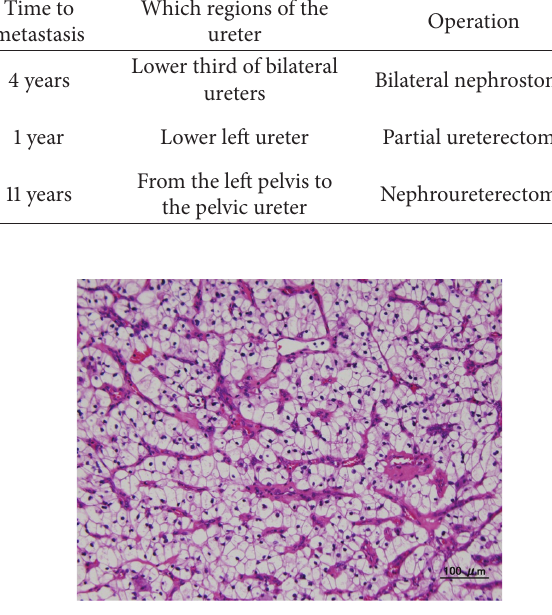
Figure 3: Histological examination revealed that the tumor was clear cell RCC, G2 > 1, with microvascular